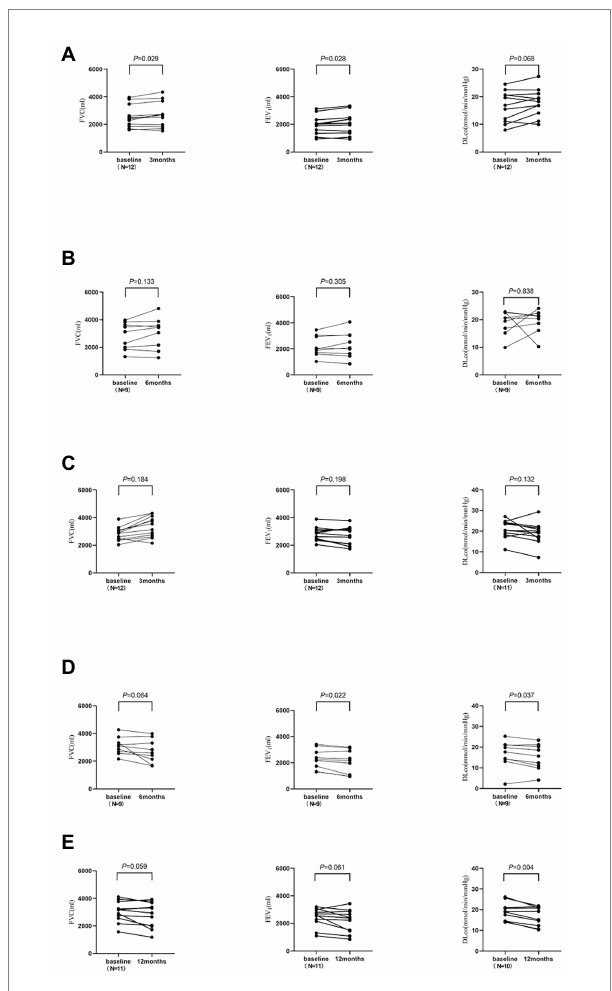
FIGURE 3 The changes of pulmonary function in the observation group and control group. DLco was not measured for one subject in each of the 3-month and 12-month cohorts. (A) The 3-month cohort of observation group. (B) The 6-month cohort of observation group. (C) The 3-month cohort of control group. (D) The 6-month cohort of control group. (E) The 12-month cohort of control group.